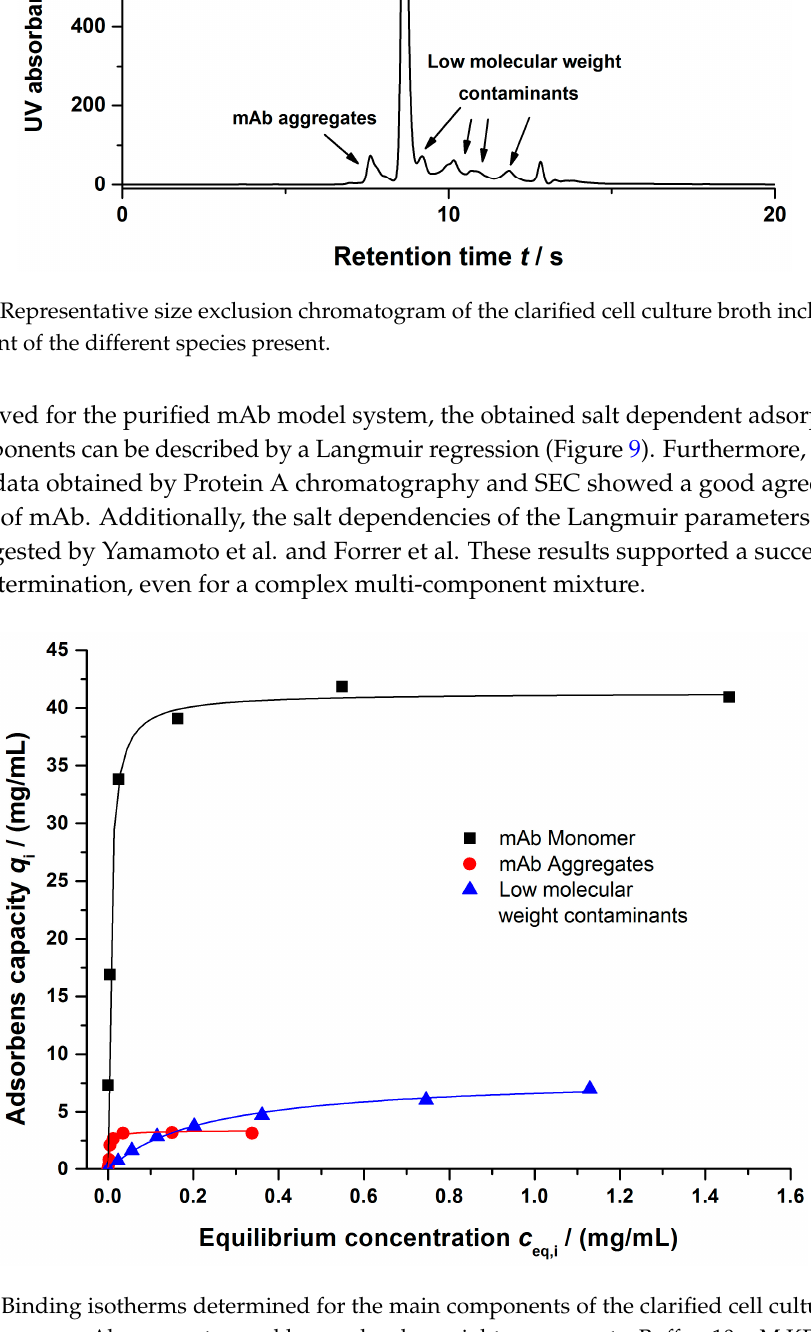
Figure 9. Binding isotherms determined for the main components of the clarified cell culture broth: mAb momomer, mAb aggregates, and low molecular weight components. Buffer: 10 mM KPi, pH = 6, 40 mM NaCl.